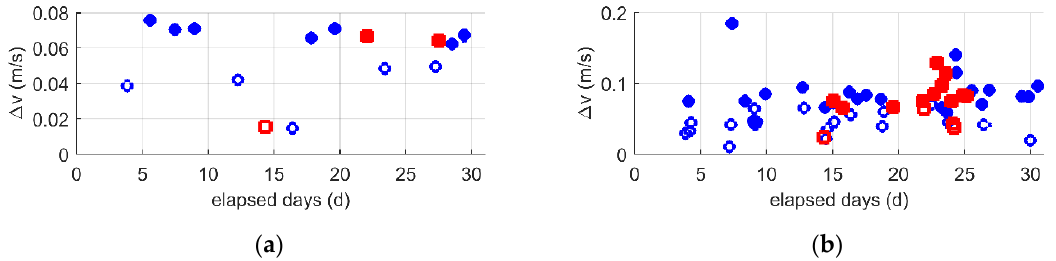
Figure 7. ∆ v required for maintenance of safety tube-based formations over the first 30 days of mission— h = 550 km. Navigation errors are: ( a ) σ p = 1 cm, σ v = 1 mm/s; ( b ) σ p = 1 cm, σ v = 5 mm/s. Blue circular markers refer to the LI scenario, while red square markers to the SS scenario. In addition, filled markers detect reconfigurations occurring because of | Y MAX | ≥ 500 m, while empty markers refer to maneuvers due to | d xz MAX